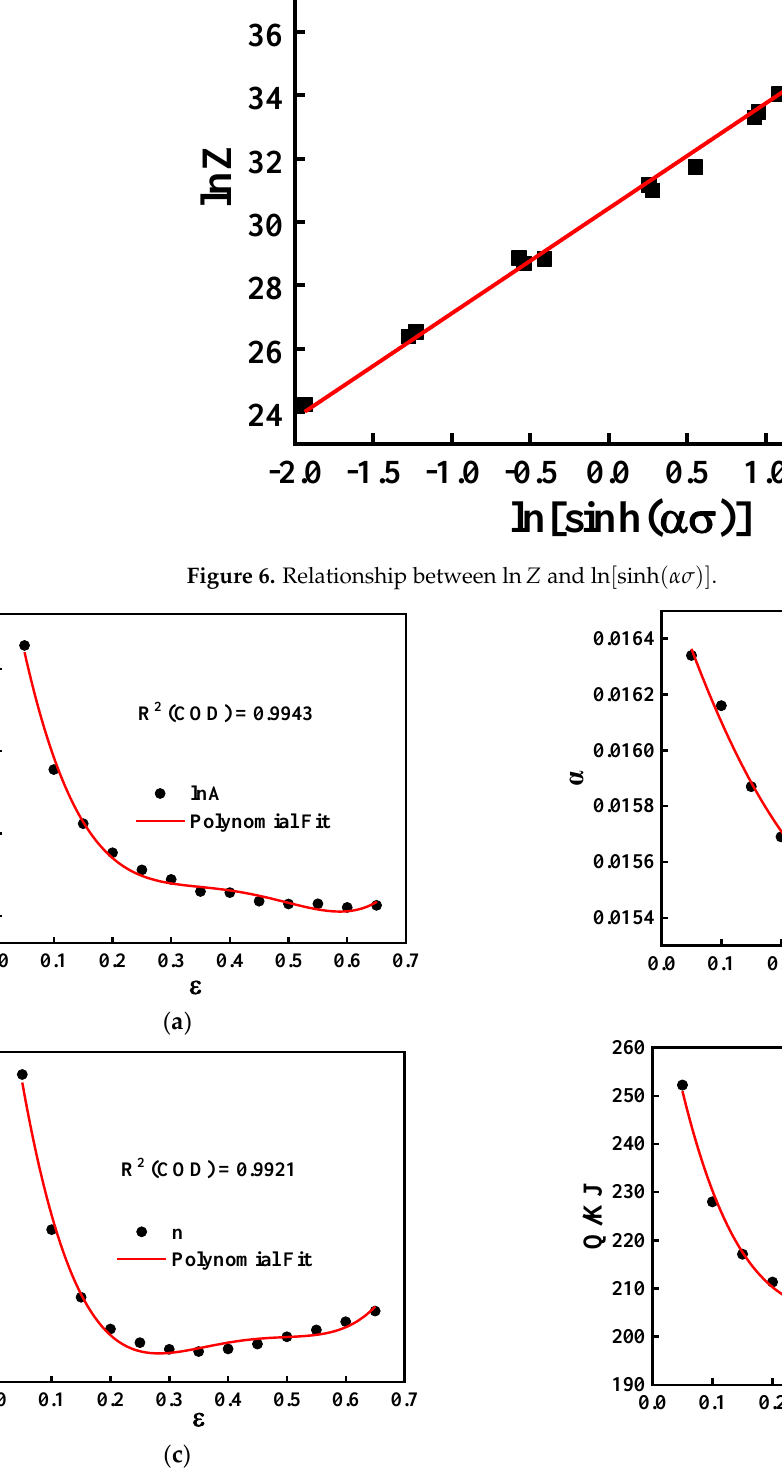
Figure 7. Relationship between: ( a ) 𝑙𝑛𝐴 and 𝜀 ; ( b ) 𝛼 and 𝜀 ; ( c ) 𝑛 and 𝜀 ; ( d ) 𝑄 and 𝜀 . The SCA constitutive model of GW103K was established after polynomial fitting. The final mathematical is expressed as Equation (6):